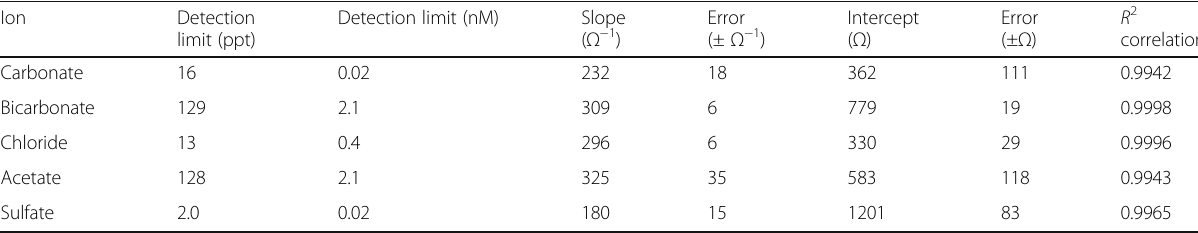
Table 3 Detection limit, calibration and goodness of fit for anions measured at 25.0 °C